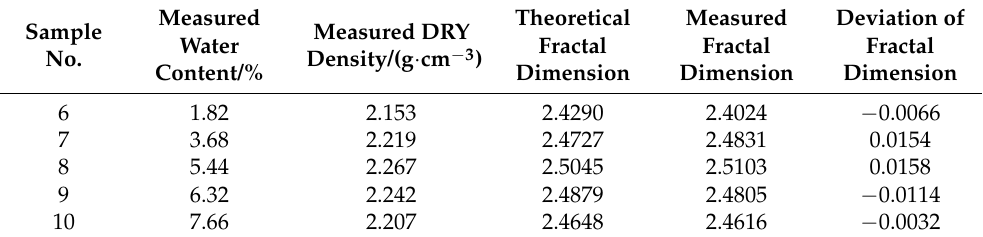
Table 6. Correlation validation results of fractal dimension with dry